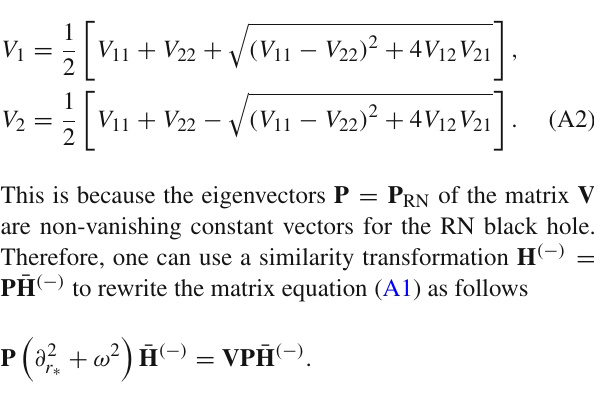
estimate the largest errors in our calculations. Note that the domain of r we are considering here is r ≥ r H , where r H is the horizon satisfying e 2 ν =